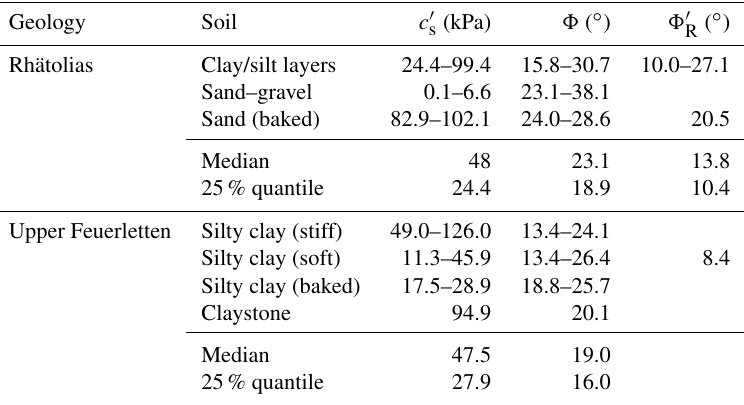
Table 1. Strength parameters according to Boley Geotechnik (2018) measured at A70 (Thurnau in Fig. 2b) with cohesion c (cid:48) s , angle of friction φ and residual angle of friction φ (cid:48) R